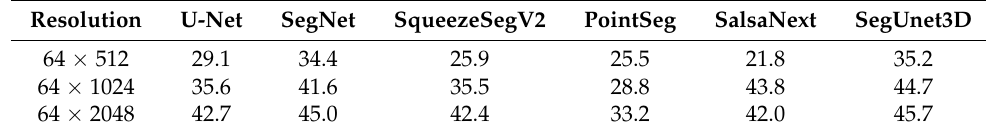
Table 1. Results of different network input size on SemanticPOSS. The values are in %. Resolution